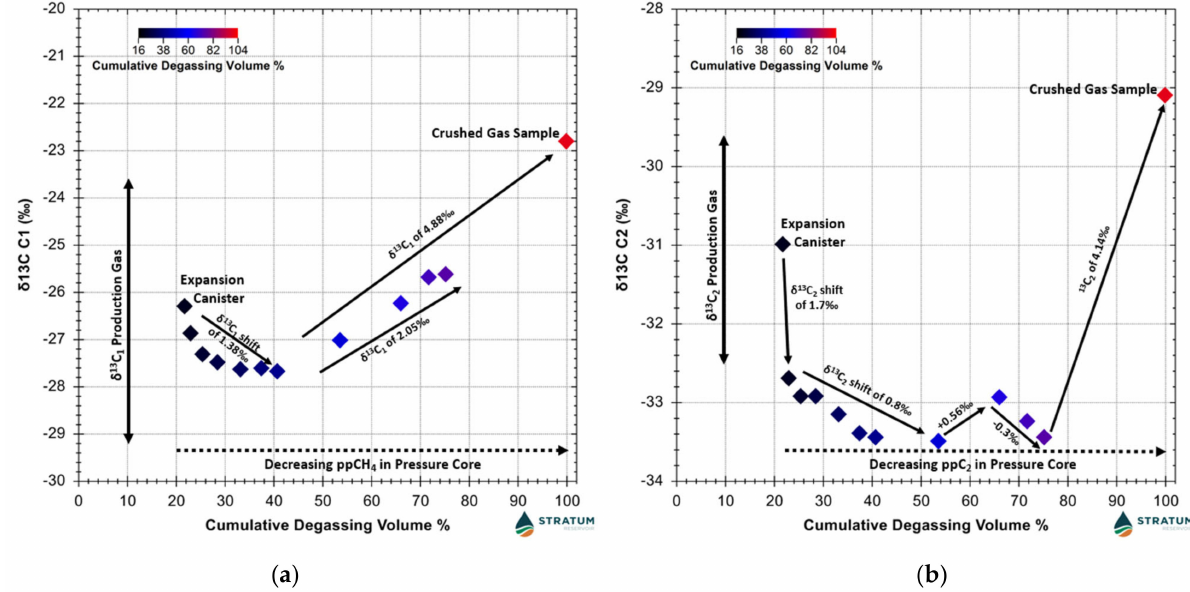
Figure 23. ( a ) Methane δ 13 C versus cumulative degassing volume for Marcellus Formation pressure core compared with the range of produced gas δ 13 C 1 in adjacent wells in Susquehanna County, Pennsylvania. ( b ) Ethane δ 13 C versus cumulative degassing volume for Marcellus Formation pressure core compared with the range of produced gas δ 13 C 2 in adjacent wells in Susquehanna County,